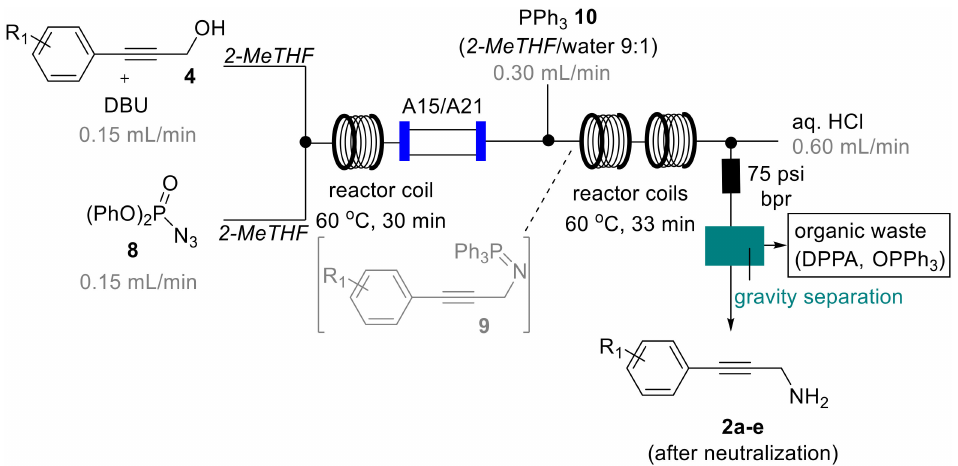
Scheme 6. Final telescoped flow process using 2-MeTHF.